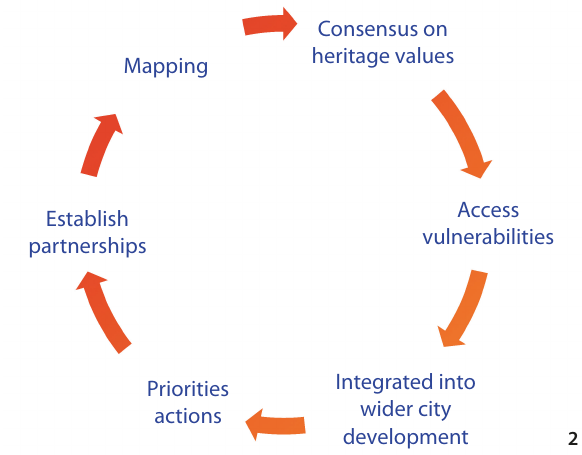
Figure 2 Action Plan for HUL approach (Source: the